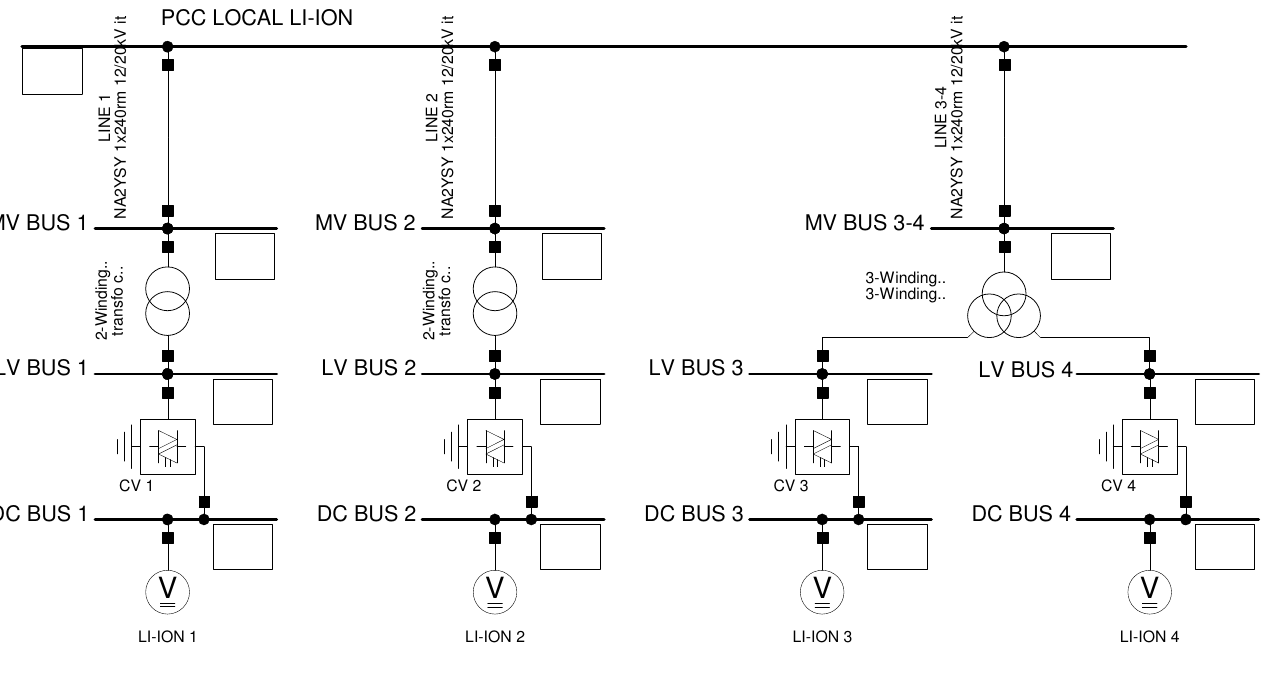
Figure 13. Battery energy storage system modeled via